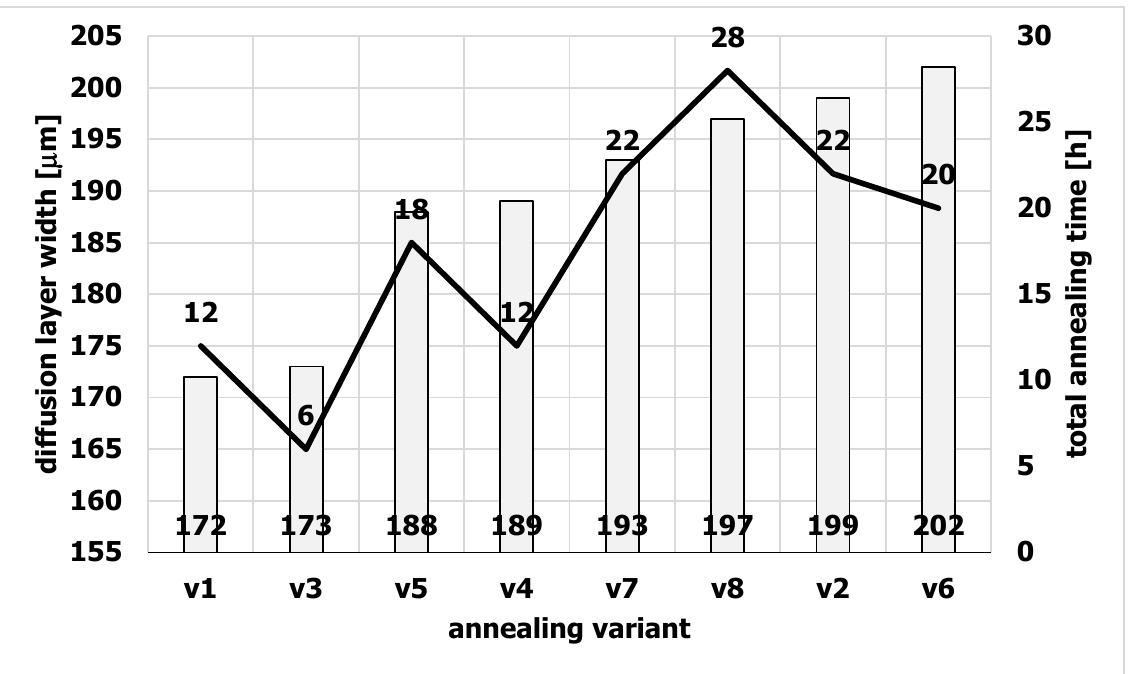
Figure 1. The width of the diffusion layer against the background of the total annealing time of the samples at the temperatures of 460 °C + 590 °C.